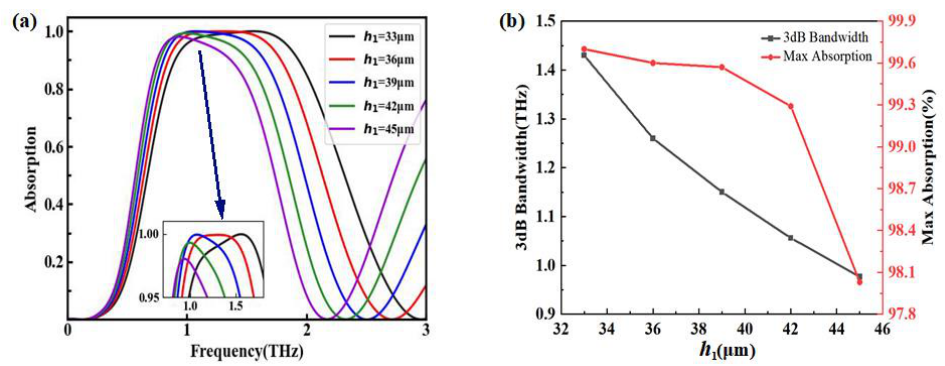
Figure 7. Absorption properties with different thickness of middle dielectric layer. ( a ) With different ℎ 1 ; ( b ) 3dB bandwidth and the maximum absorption with different ℎ 1